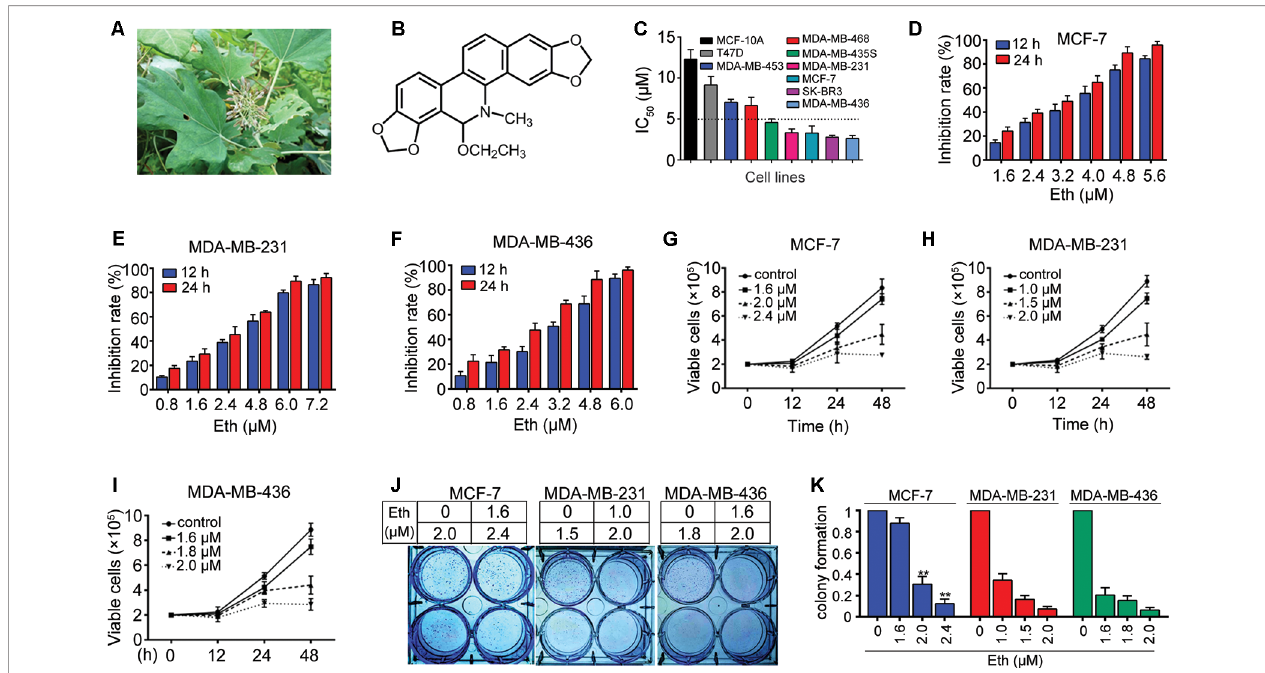
FIGURE 1 | Eth inhibits BC cells. (A) : M. cordata image. (B) : Chemical structure of Eth. (C) : The IC 50 of Eth for indicated cell lines. (D – F) : The inhibitory effects of Eth on MCF-7, MDA-MB-231, and MDA-MB-436 cells analyzed by MTT assay. (G – I) : Inhibitory effects of Eth on cell viability of MCF-7, MDA-MB-231, and MDA- MB-436 cells assayed by trypan blue exclusion assay. (J – K) : The colony formation assays of MCF-7, MDA-MB-231, and MDA-MB-436 cells treated with Eth at indicated concentration. ** P <